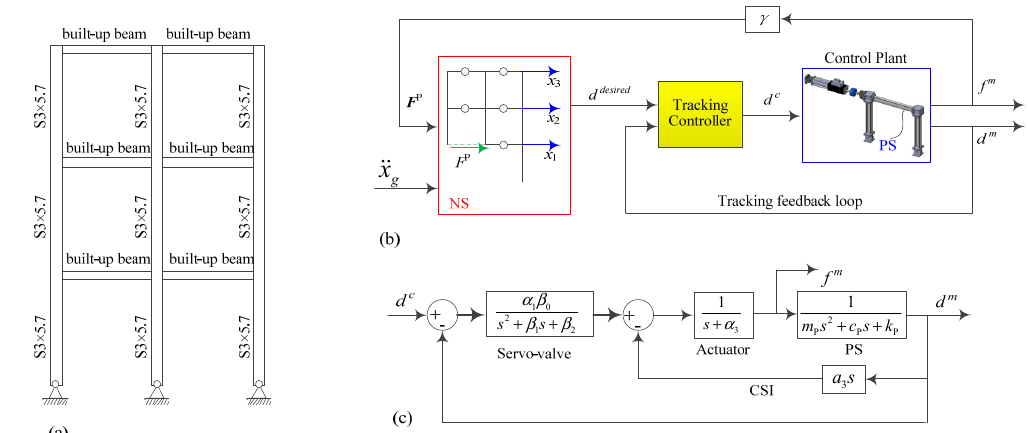
Figure 1. Block diagram of the Benchmark problem in RTHS. ( a ) Benchmark structure; ( b ) typical RTHS system; ( c ) block diagram of the control plant.